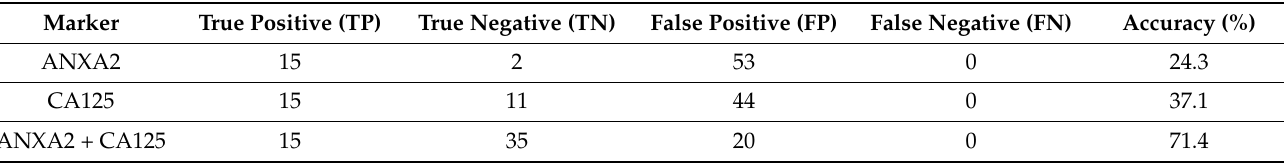
Table 4. Accuracy (%) of ANXA2, CA125 and ANXA2 + CA125 calculated from the proportion of true positives,